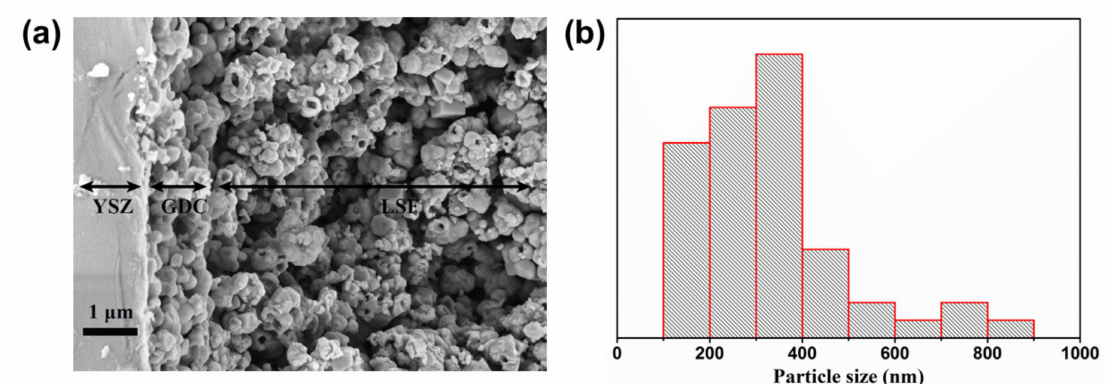
Figure 5. Interface of yttria-stabilized zirconia (YSZ) electrolyte / Gd 0.1 Ce 0.9 O 1.95 (GDC) interlayer / LSF oxygen electrode in the directly assembled button cell ( a ) and the particle size distribution of LSF grains ( b